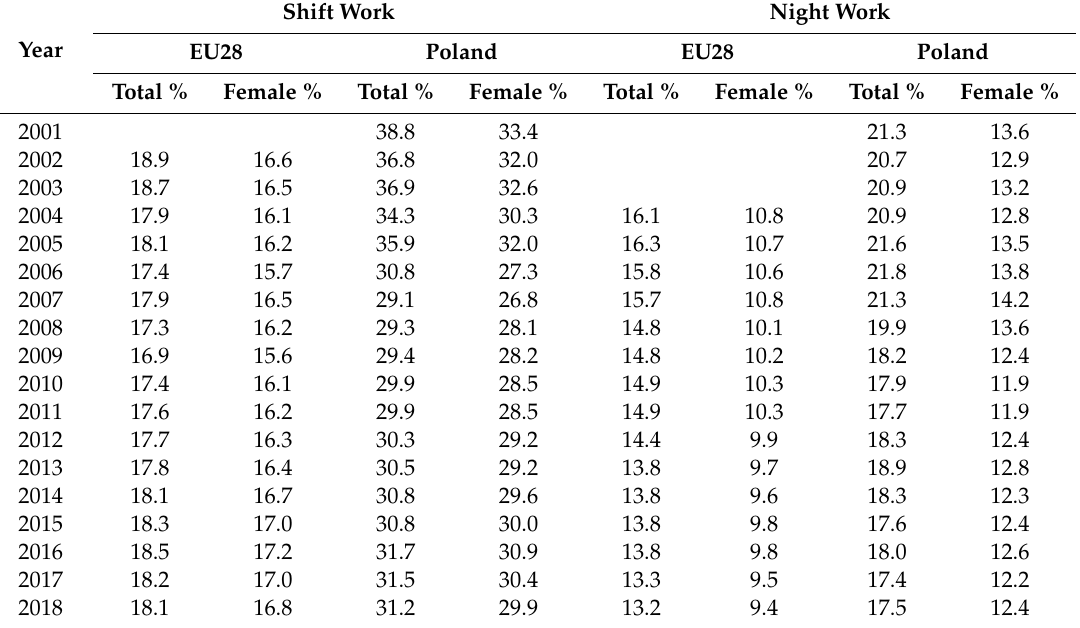
Table 1. Employees working shifts and nights as a percentage of the total of employees (based on Eurostat).